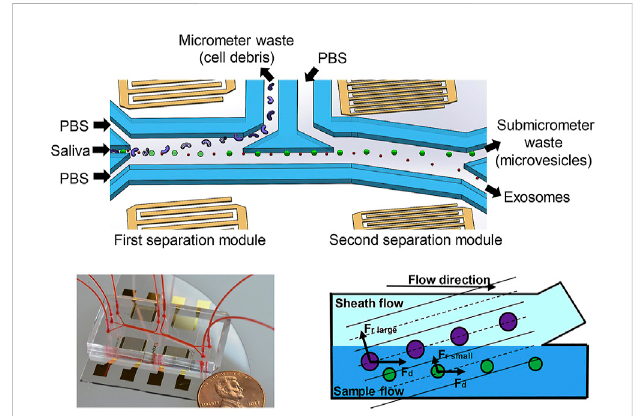
FIGURE 3 Schematic diagram of an acoustic fl uid device for salivary exosome isolation. Micrometer and submicrometer waste can be separated by using 20 MHz and 40 MHz surface sound waves. During the separation process, the particles are subjected to the acoustic radiation force andthedragforce.Exosomescanbeseparatedinthesecondseparation module. Reproduced with permission from (Wang et al.,